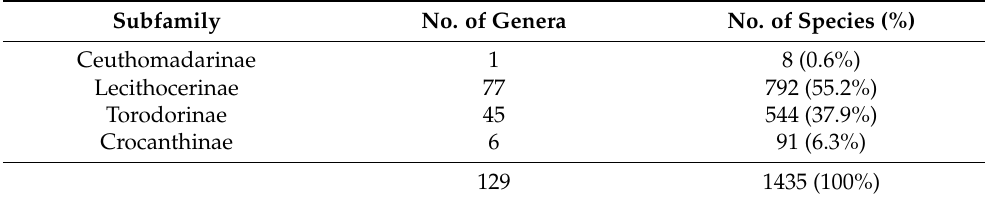
Table 1. Number of the genus and species of the family Lecithoceridae.